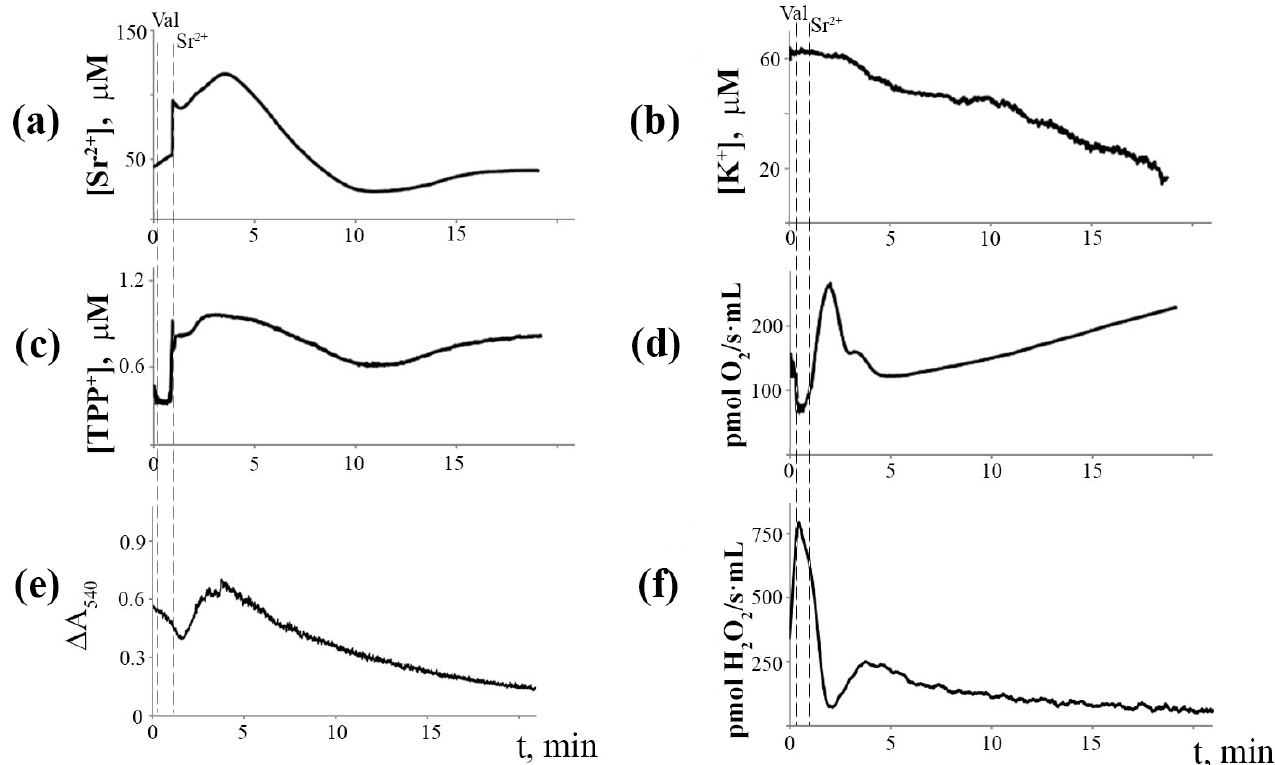
Figure 6. Blocking effect of aristolochic acid (25 µM), a phospholipase A 2 inhibitor, on Sr 2+ /valinomycin-induced cyclic changes in the fluxes of Sr 2+ ( a ), K + ( b ), TPP + ( c ), respiration rate ( d ), matrix volume ( e ), and H 2 O 2 production rate ( f ) in rat liver mitochondria. The medium and conditions were the same as in Figure 2. Additions: 2 ng valinomycin and 45 nmol SrCl 2 /mg of protein. The typical traces are presented ( n = 5).